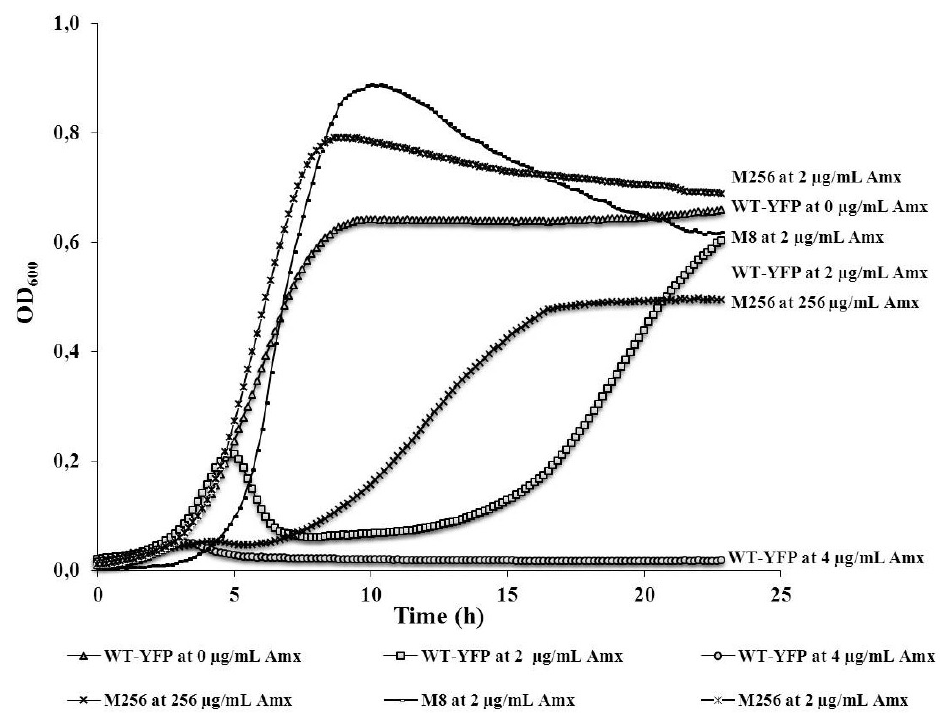
Figure 1. Representative growth curves of variants of E. coli MG1655 at different concentrations of amoxicillin. WT-YFP (wild-type-yellow fluorescent protein), the amoxicillin-susceptible variant (MIC 4 µg/mL), with genes coding for a yellow fluorescent protein and chloramphenicol resistance. M256, the strain derived from E. coli WT MG1655 by growing it at stepwise increasing amoxicillin concentrations. M8, WT-YFP after five days of growth at 2 µg/mL (MIC 32 µg/mL).